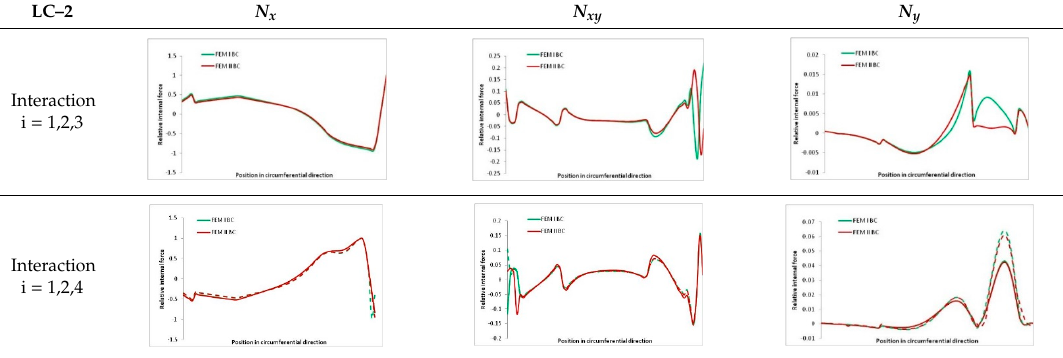
Table 16. Internal forces in LC–2 beam under the load corresponding to the first failure and the load-carrying capacity.